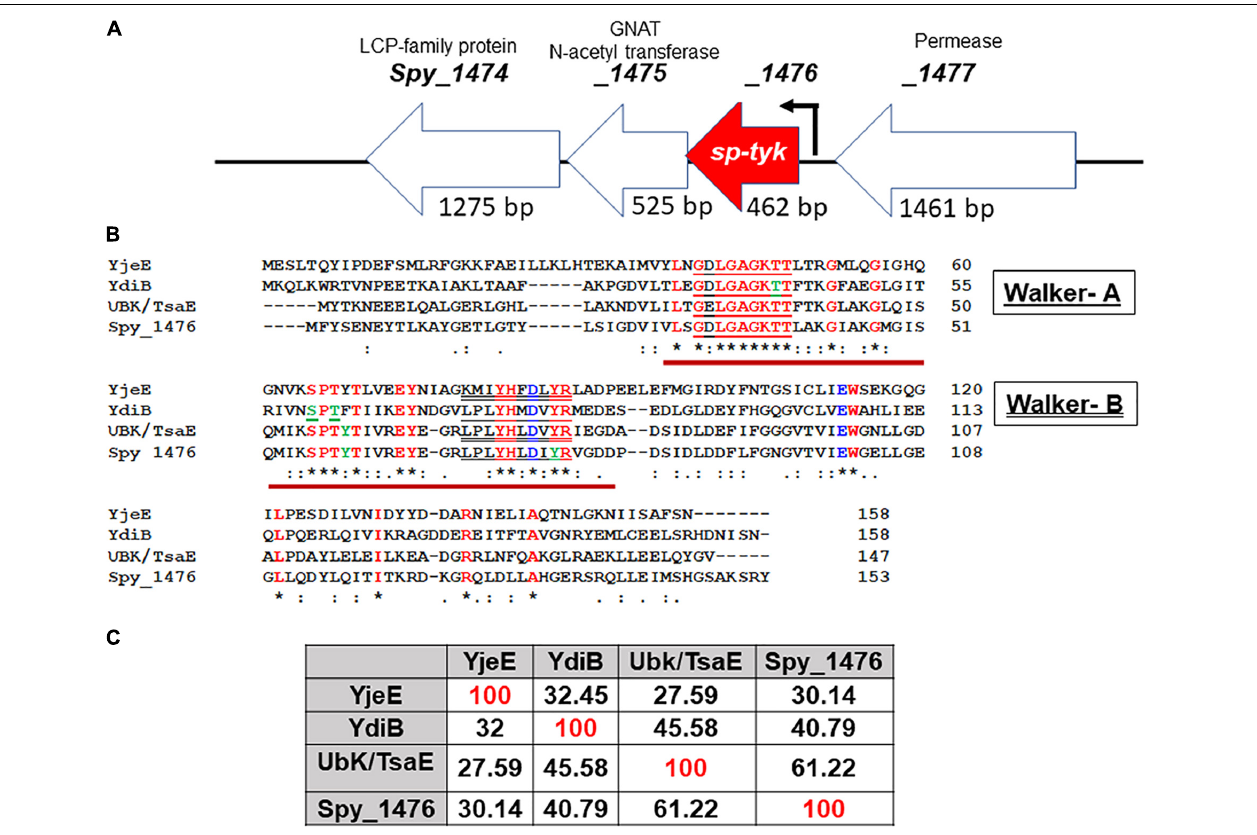
FIGURE 1 | Genomic background of the spy_1476 / sp-tyk gene and its comparison with other homologs. (A) The genomic environment of Spy_1476 (462 bp) and flanking genes. (see the conserved operon in gram-positive and gram-negative bacteria Supplementary Table 7 ). The flanking genes upstream spy_1477 (1,461 bp) and downstream genes spy_1475 (525 bp) and spy_1474 (1,275 bp), respectively, encode permease, GNAT N -Acetyltransferase, and Lytr-Cps2A-Psr (LCP)-family protein. Arrow indicates transcription start site and the predicted promoter. (B) Protein sequence of Spy_1476 and its comparison with other homologs. Yje, YdiB, and UbK/TsaE were identified in Haemophilus influenzae , Bacillus subtilis , and Streptococcus pneumoniae, as indicated. Bold letters in red fonts are the conserved regions in these proteins. Letters in green fonts indicate the identified phosphorylated residues. Brown underline indicates catalytic site represented by Walker-A [red underline, GX(4)GKT(S)] and Walker–B (double underline, (RK)-X(3)-G-X(3)-L-h(3)D) motifs, where “h” stands for hydrophobic residues. Symbol “ * ” denotes identical conserved residues, and “ : ” denotes similar conserved residues. (C) Percent sequence identity of Spy_1476 with other homologs.